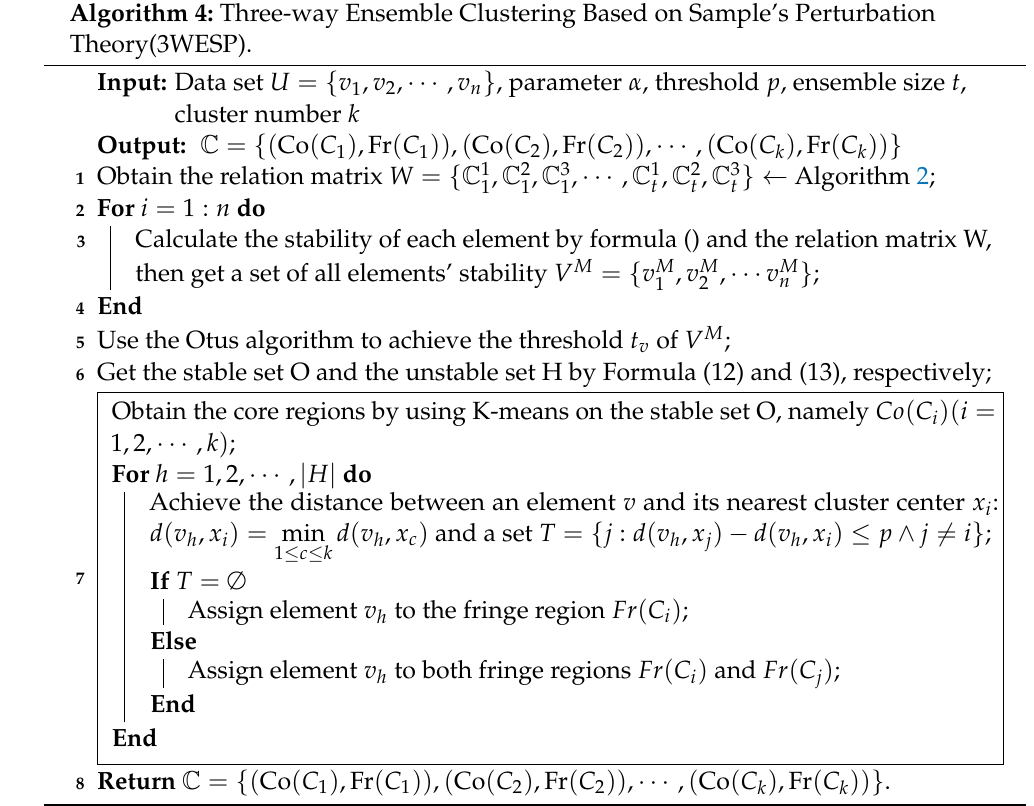
Algorithm 4: Three-way Ensemble Clustering Based on Sample’s Perturbation